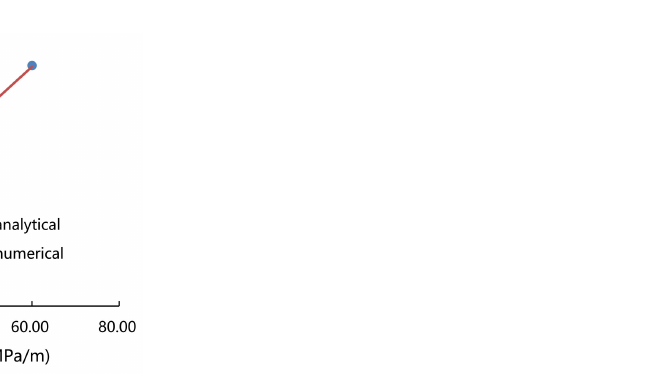
Figure 8. Comparison between analytical and numerical results of Poiseuille flow with consideration of slip.